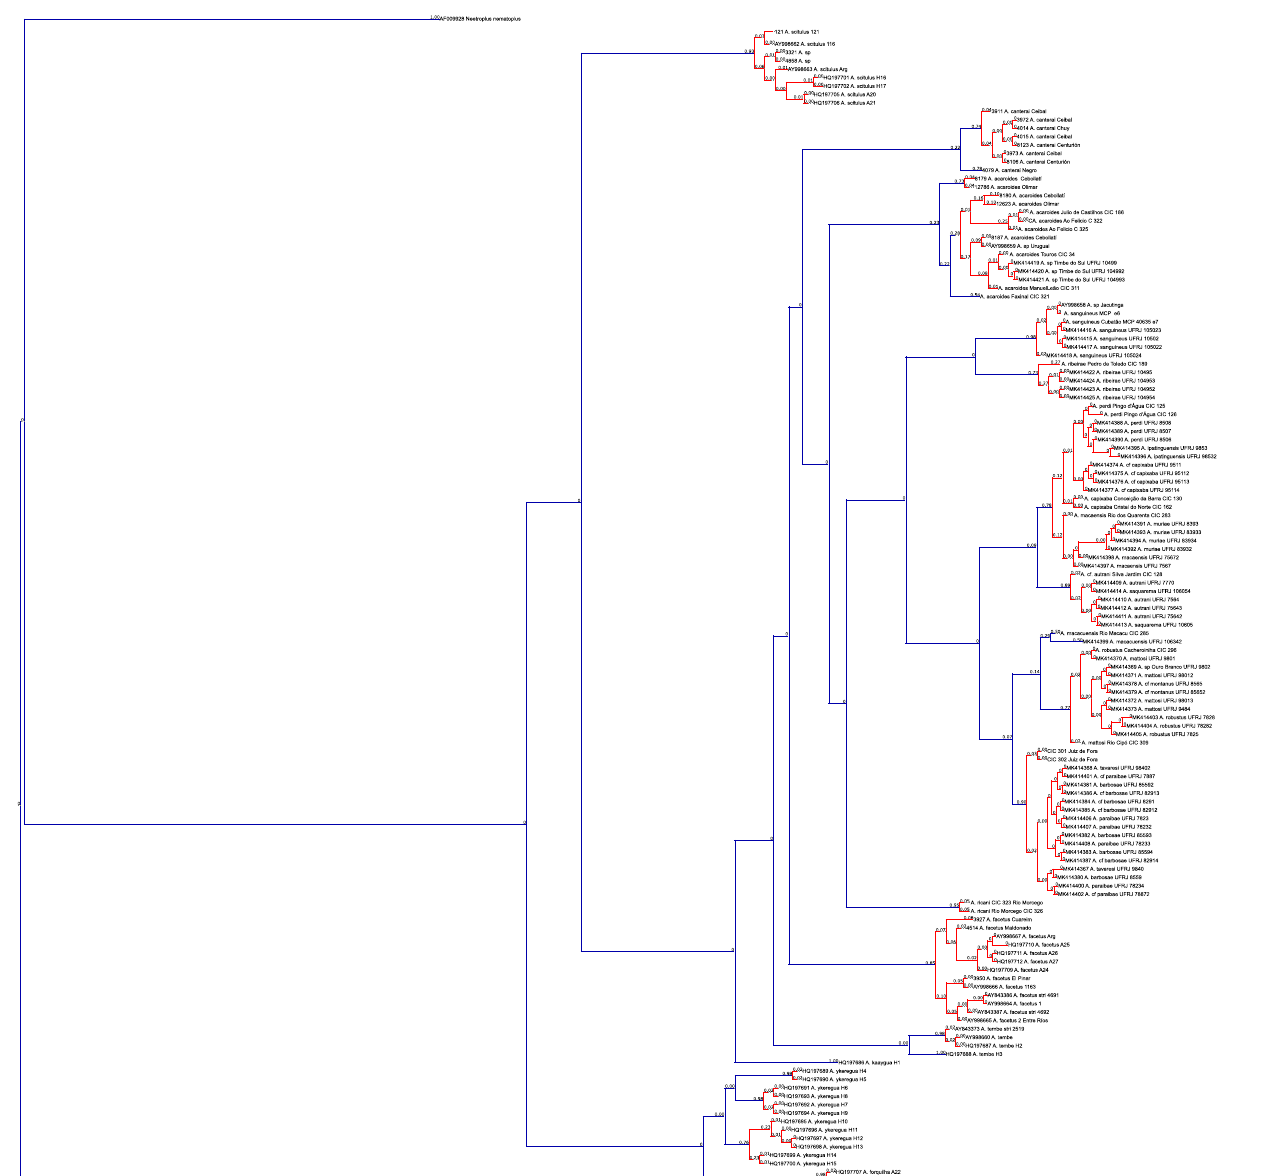
Fig 12. Delimitation of species of Australoheros based on bPTP analysis of mt-cyb sequences. Blue lines lead to suggested species; red lines combine within-species branches. Node numbers are percentage support values generated by bPTP. OTU names are as those considered as valid species; nominal species identified by locality are indicated by codes inserted within parentheses: AU = A . autrani ; BB = A . barbosae , CP = A . capixaba ; MA = A . macaensis , MC = A . macacuensis ; MU = A . muriae ; PB = A . paraibae .